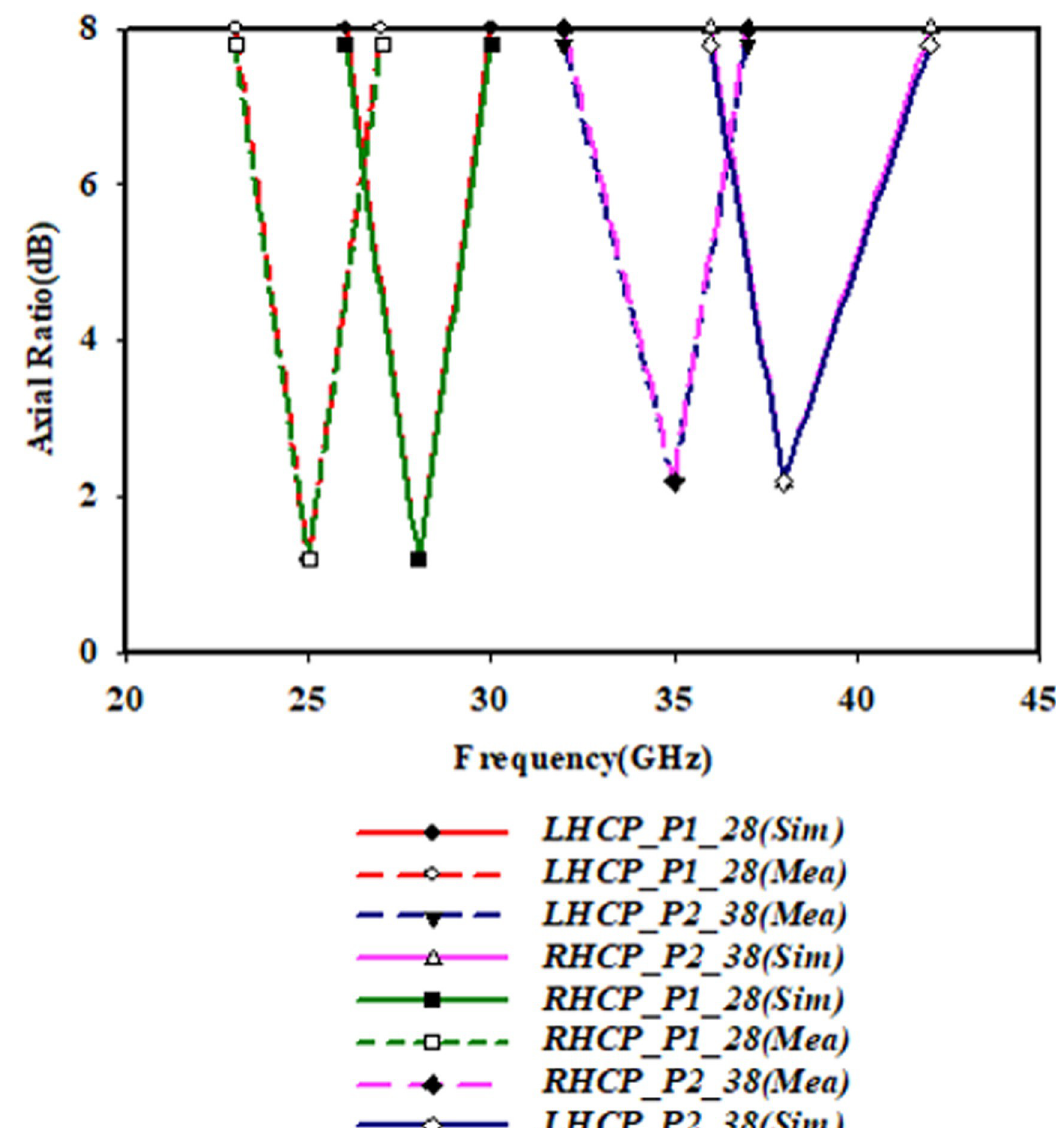
Fig 6. Simulated and measured results of P1_28 & P2_38 patches AR at y = 1.2